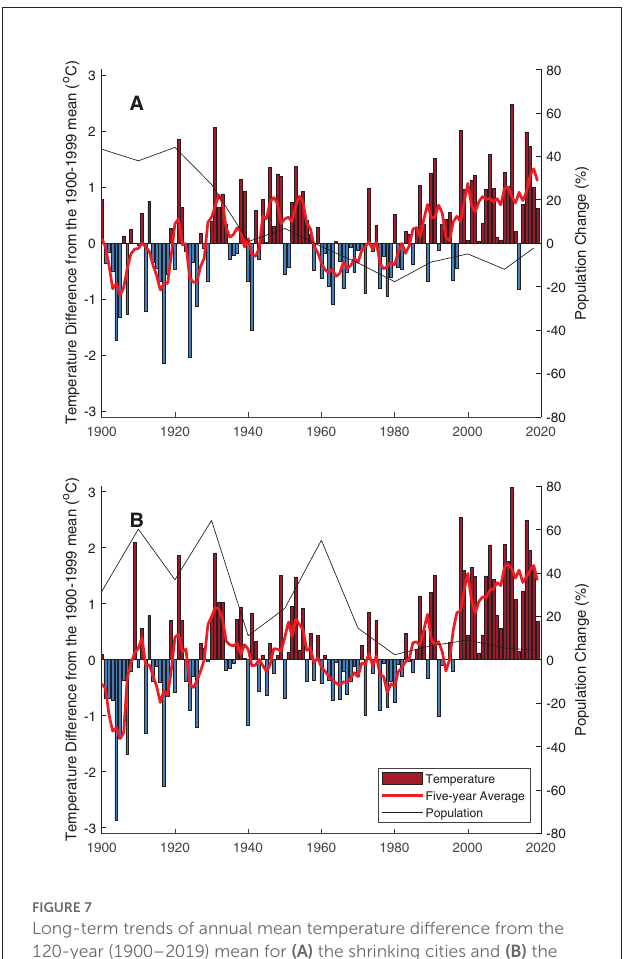
FIGURE7 Long-term trends of annual mean temperature difference from the 120-year (1900–2019) mean for (A) the shrinking cities and (B) the growing city.